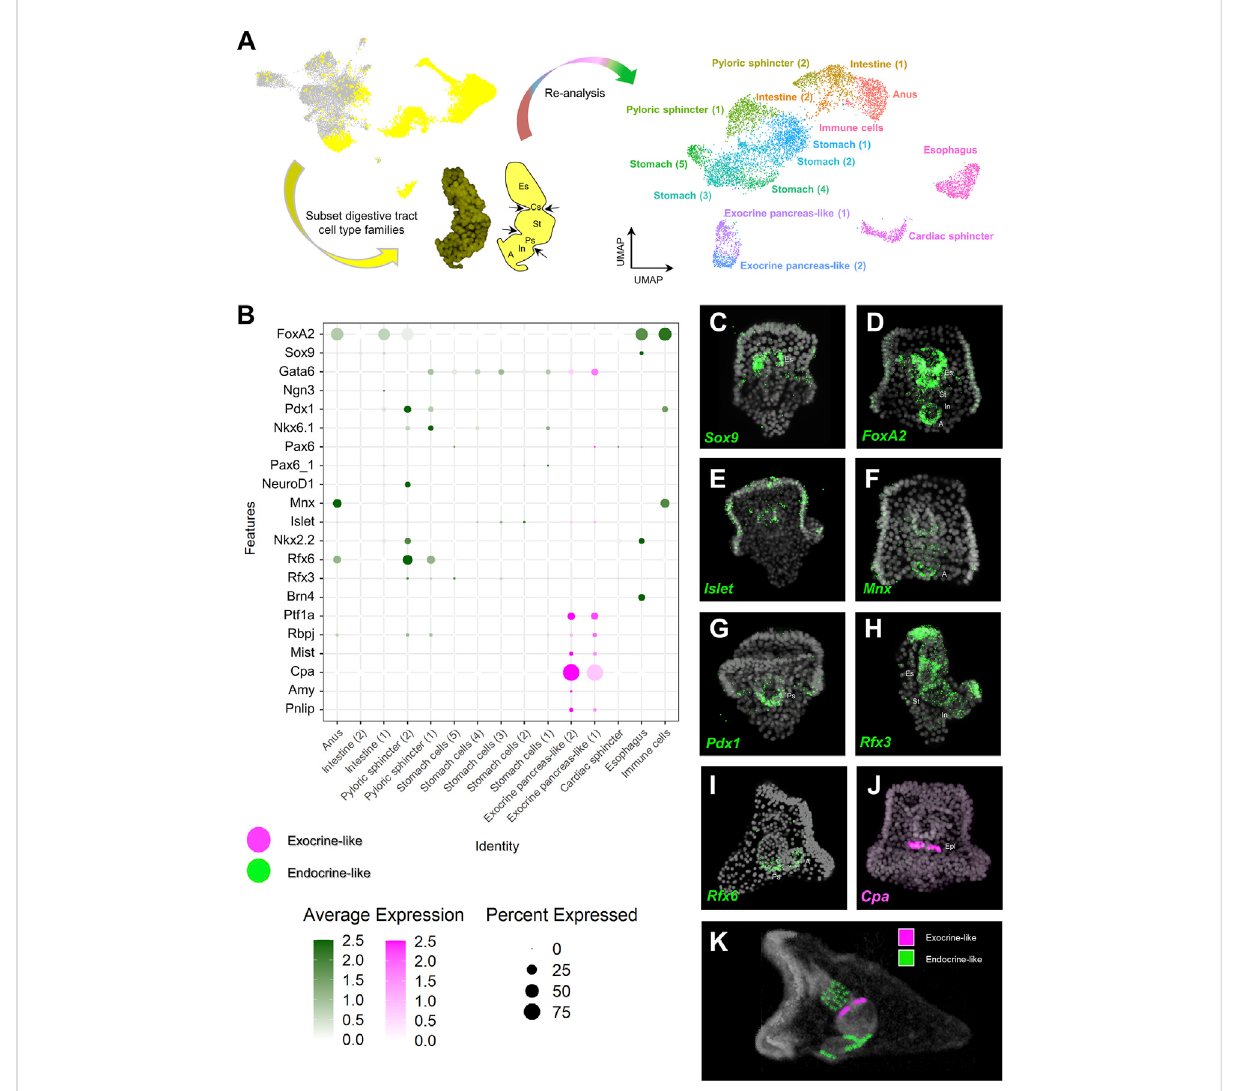
FIGURE 2 Distribution of endocrine and exocrine pancreas-like markers across the digestive tract. (A) Summary of the pipeline used to increase the resolution of the digestive tract cell type composition. Digestive tract related cell type families are highlighted in yellow (left), subsetted and subclustered resulting in the generation of 15 clusters (right). (B) Dotplot showing the average expression of pancreatic gene markers across the digestive tract subclustered dataset. Colored boxes are used to highlight endocrine-like (green) and exocrine-like (magenta) molecular signatures. (C – J) FISHusingantisenseprobesdesignedagainstseveralofthepancreaticmarkersusedin (B) .Colorcodeofthesignalisthesameasin (B) . DAPI was used to label the nuclei (gray). (K) MicroCT of the 3 dpf S. purpuratus pluteus larva, placed in lateral view, in which the